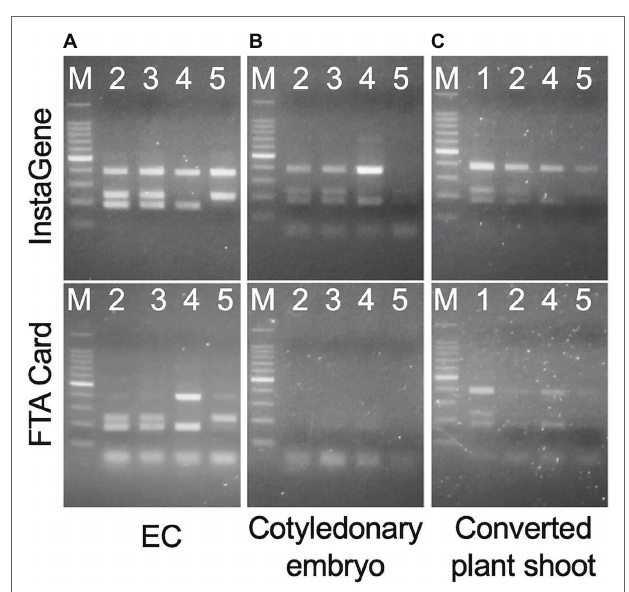
FIGURE 5 | Amplification of one-step indel genotyping (ING) marker from EC (A) , cotyledonary embryo (B) , and developed plant shoot (C) extracted by InstaGene (top) and FTA Card (bottom). M: 100 bp ladder marker, 1: FO7-97, 2: FO7-141, 3: FO7-144, 4: SSD-18, 5: T4-11-51.